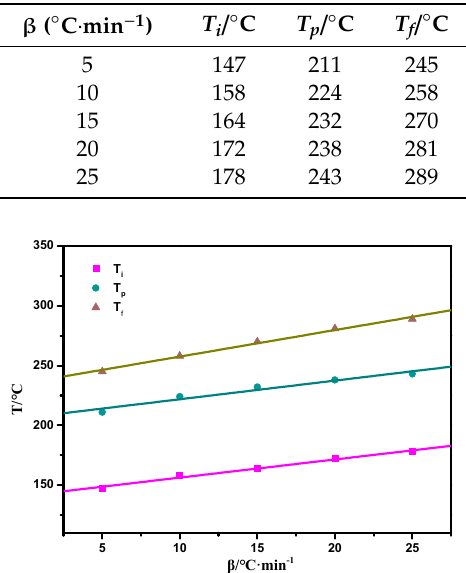
Table 1. Peak temperature at di ff erent heating rates.